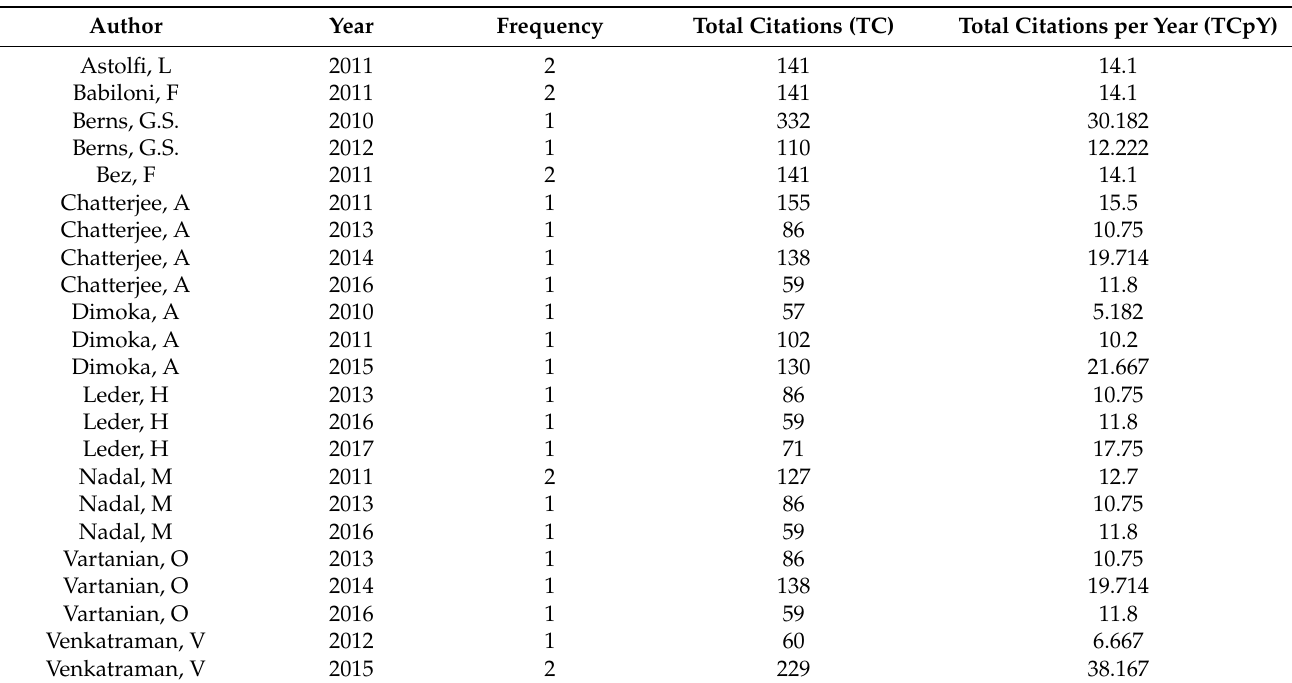
Table 10. Top 10 Authors’ Production Over the